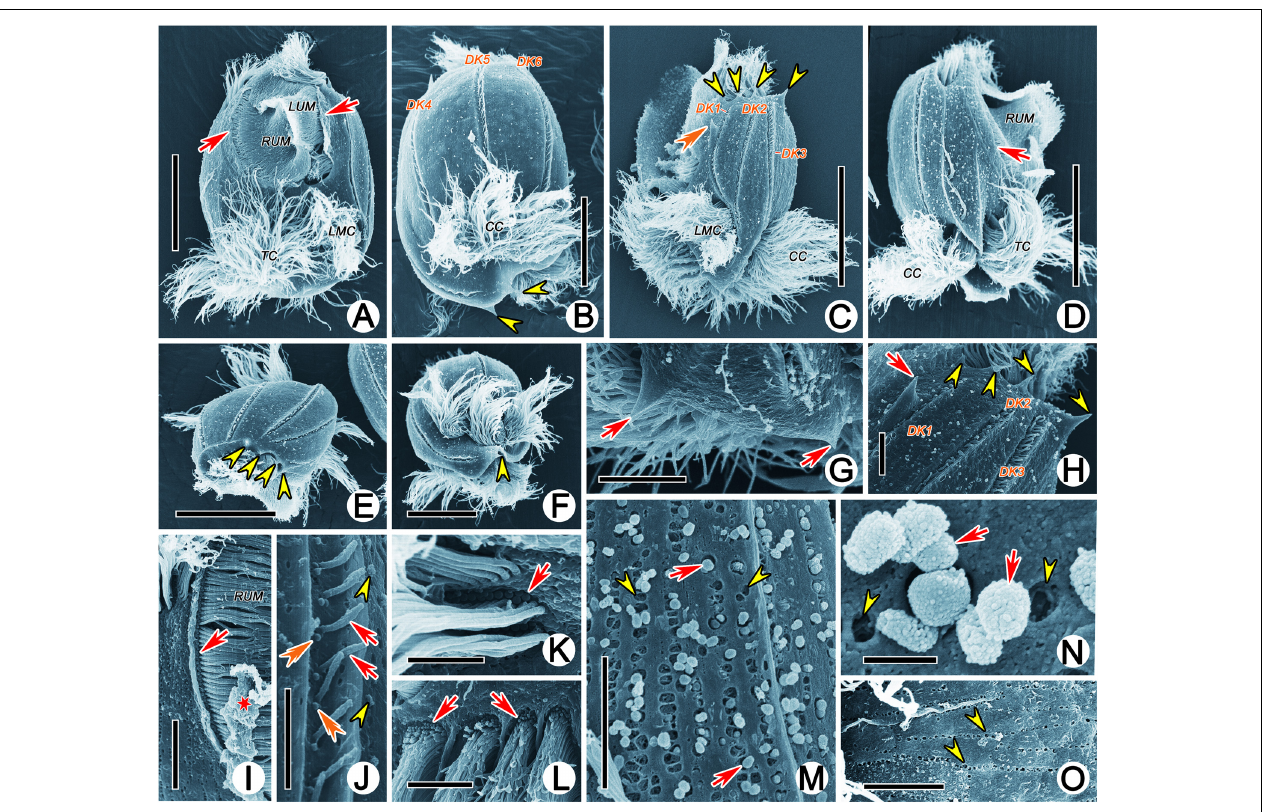
FIGURE 2 | Scanning electron micrographs of Uronychia binucleata . (A–F) Ventral (A) , dorsal (B) , left lateral (C) , right lateral (D) , top (E) and bottom (F) views of representative individuals. Arrows indicate the cortical flap upon right and left components of the undulating membrane, arrowheads point to the protruding spines of both ends of the cell, double-arrowhead shows the large spine near the left dorsal kinety 1. (G) Posterior end of cell to show the two spines (arrows) pointed backward. (H) Anterior end of cell showing the four spines (arrowheads) protruding from anterior end and the large spine (arrow) near the left of dorsal kinety 1. (I) Proximal of right component of the undulating membrane to show the basal bodies without cilia (arrow). Asterisk indicates the broken cortical flap. (J) Cortical groove with dorsal kineties (arrows), showing the two basal bodies, one of which was barren of cilia (double-arrowhead). Arrowheads mark extrusomes. (K,L) Basal bodies are barren of cilia (arrows) in left marginal (K) and transverse (L) cirri. (M) Extruding or extruded extrusomes (arrows) arranged in short rows. Arrowheads point to residual “pits.” (N) Apical view of extruded extrusomes (arrows) sticking together. Arrowheads show residual “pits.” (O) Residual “pit” (arrowhead) after extrusome has been extruded, arranged in short rows. CC, caudal cirri; DK1–6, dorsal kineties 1–6; LMC, left marginal cirri; LUM, left component of the undulating membrane; TC, transverse cirri; RUM, right component of the undulating membrane. Scale bars = 30 µ m (A,C–E) , 20 µ m (B,F) , 5 µ m (G–I,L,M,O) , 3 µ m (J) , 2 µ m (K) , 0.5 µ m (N)